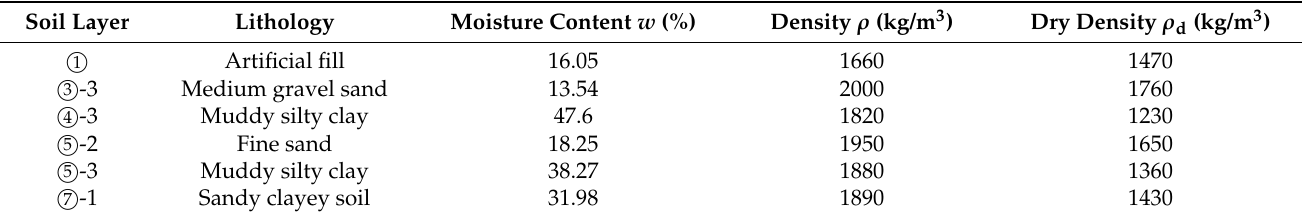
Table 1. Properties of typical soil layers in Gongbei Tunnel.